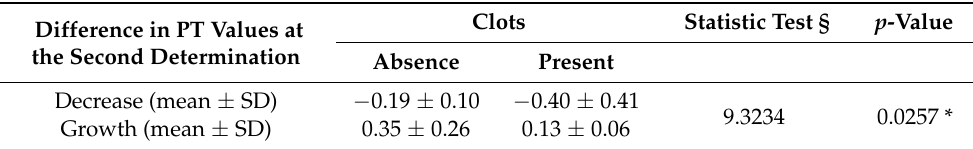
Table 6. Mean values of differences between the first and second determinations, depending on the presence of clots. Clots Difference in PT Values at the Second Determination Absence Present Table 7. Total Bilirubin (TB) and Direct Bilirubin (DB) values according to the evolution of the PT Decrease (mean ± SD) − 0.19 ± 0.10 − 0.40 ± 0.41 test at the second determination.